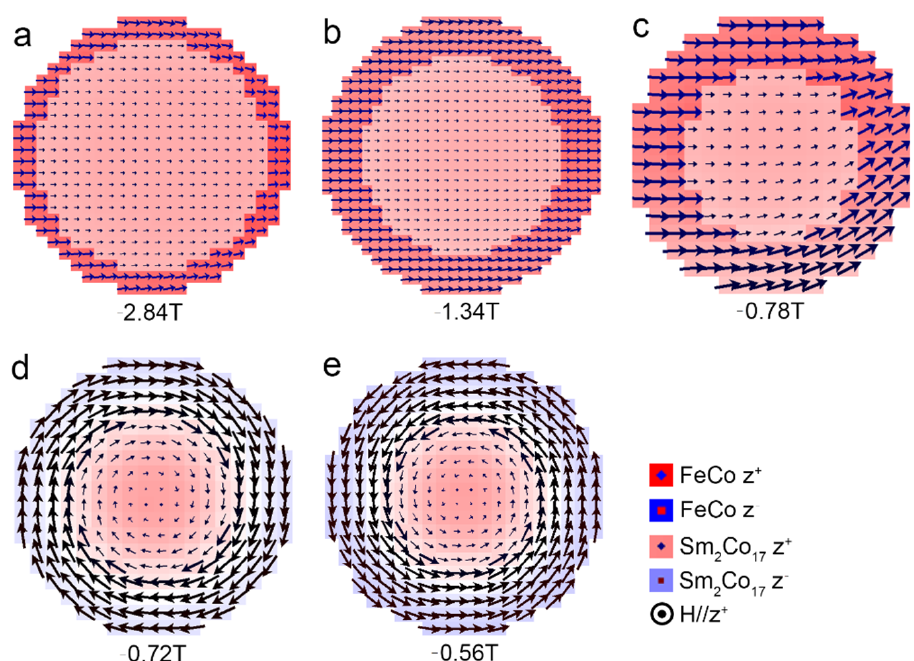
Figure 3. Magnetic structures close to the coercivity of the core/shell cylinders with aspect ratio L / D = 1 and ( a ) t = 1 nm, ( b ) t = 2 nm, ( c ) t = 3 nm, ( d ) t = 4 nm, ( e ) t = 5 nm. The observation plane is perpendicular to the applied field ( z -axis direction).